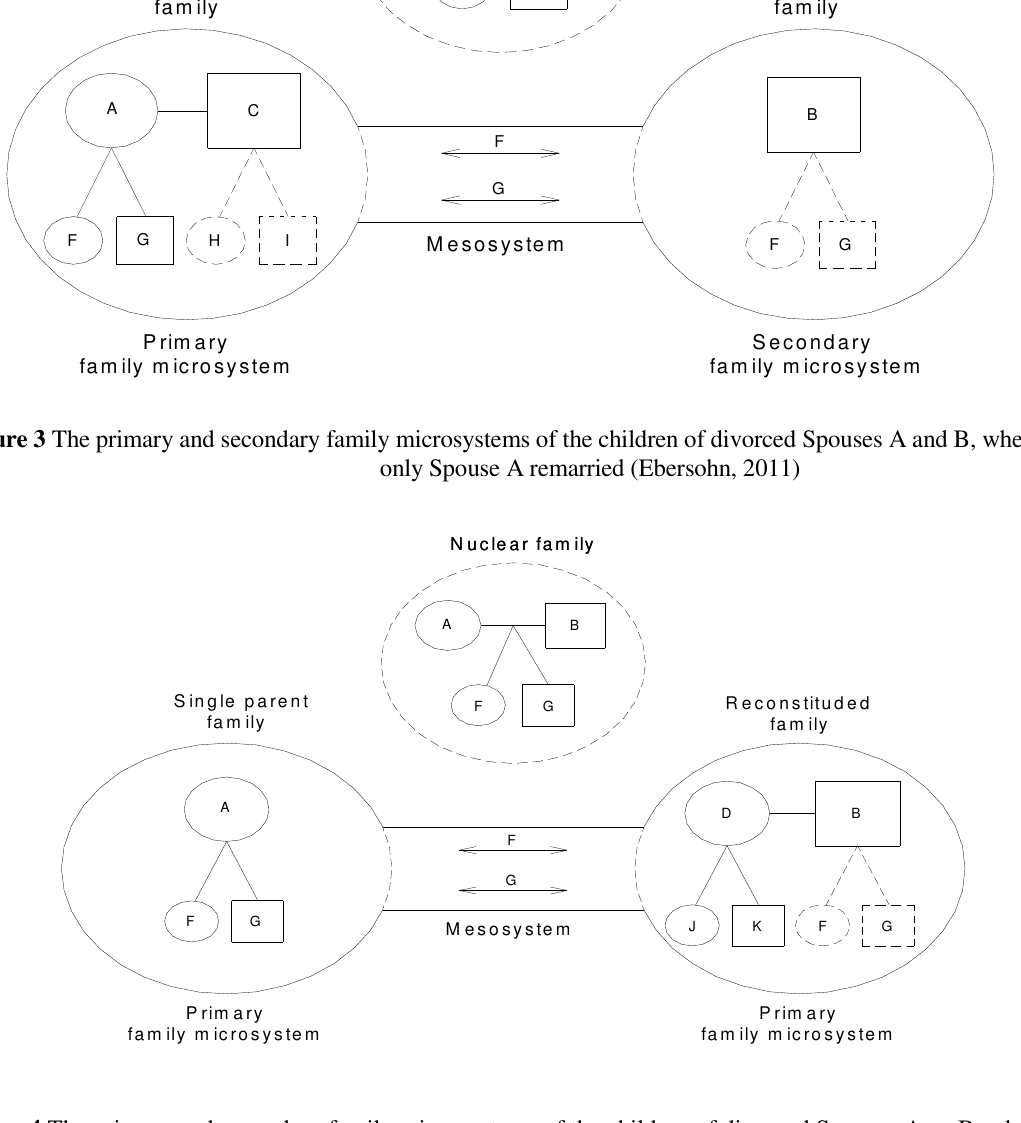
Figure 4 The primary and secondary family microsystems of the children of divorced Spouses A en B, where only Spouse B remarried (Ebersohn,